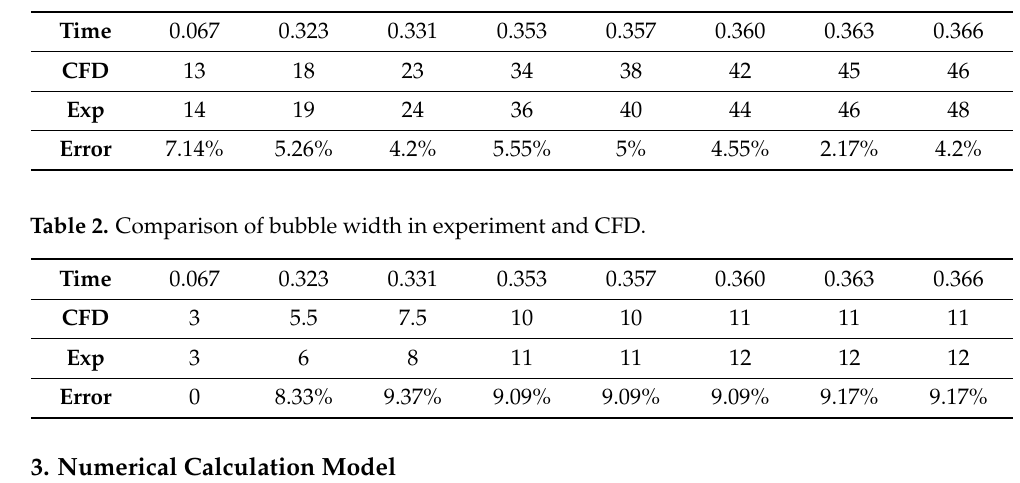
Table 1. Comparison of bubble length in experiment and CFD.